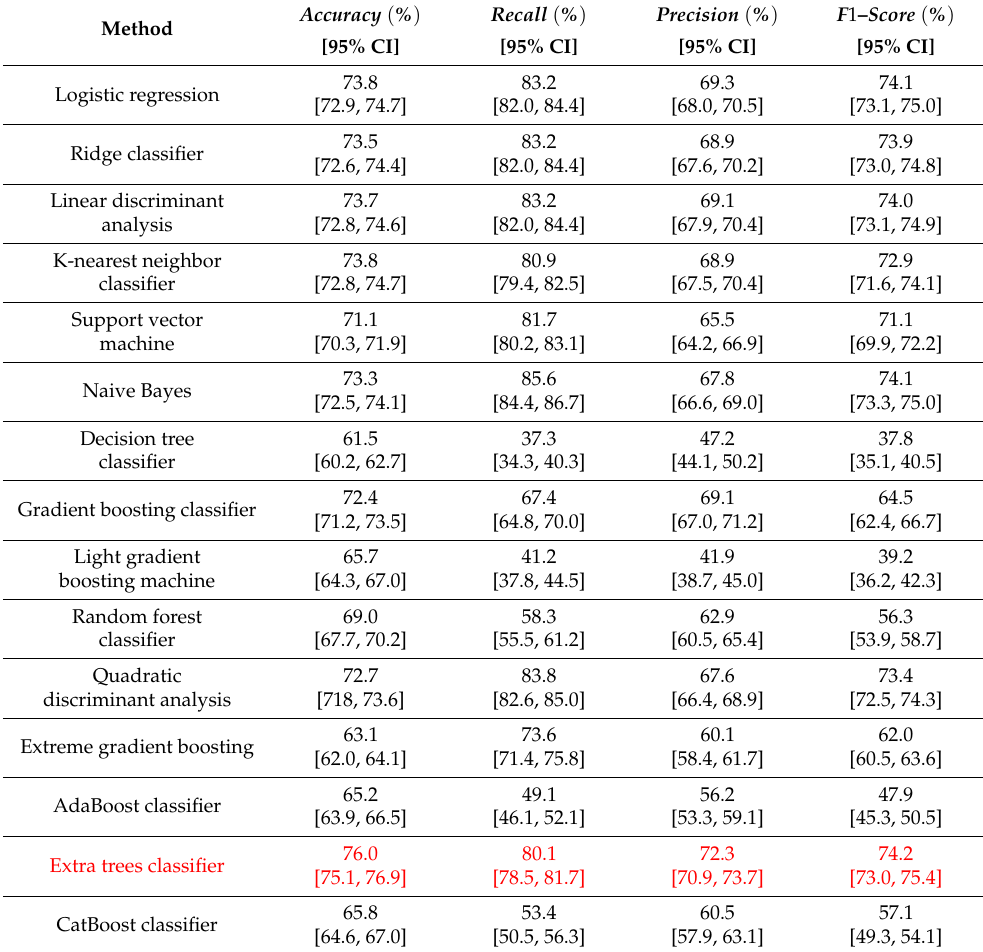
Table 6. Averaged accuracy , recall , precision , and F 1 − score and their 95% CI of 15 ML methods using three principal components (PCs) of principal component analysis (PCA) extracted from whole hemodynamic features for classification of AD and WT. Each method was performed 600 times by shuffling the data due to limited data sets. The results and the name of the ML method with the best accuracy (extra trees classifier) are highlighted in